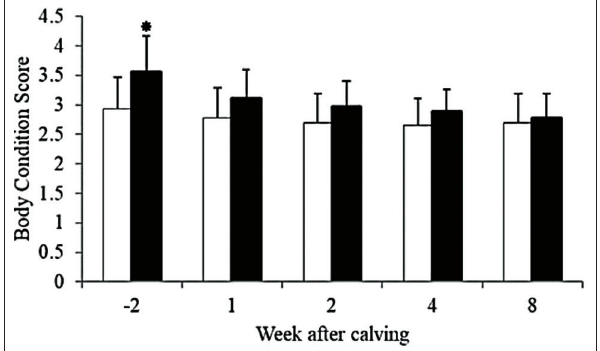
Figure-3: Dynamics of serum glucose concentration at 2 weeks before expect calving date and 1, 2, 4, and 8 weeks after parturition of smallholder (□, n=15) and semi-commercial ( , n=17), error bars stand for standard deviation. ■